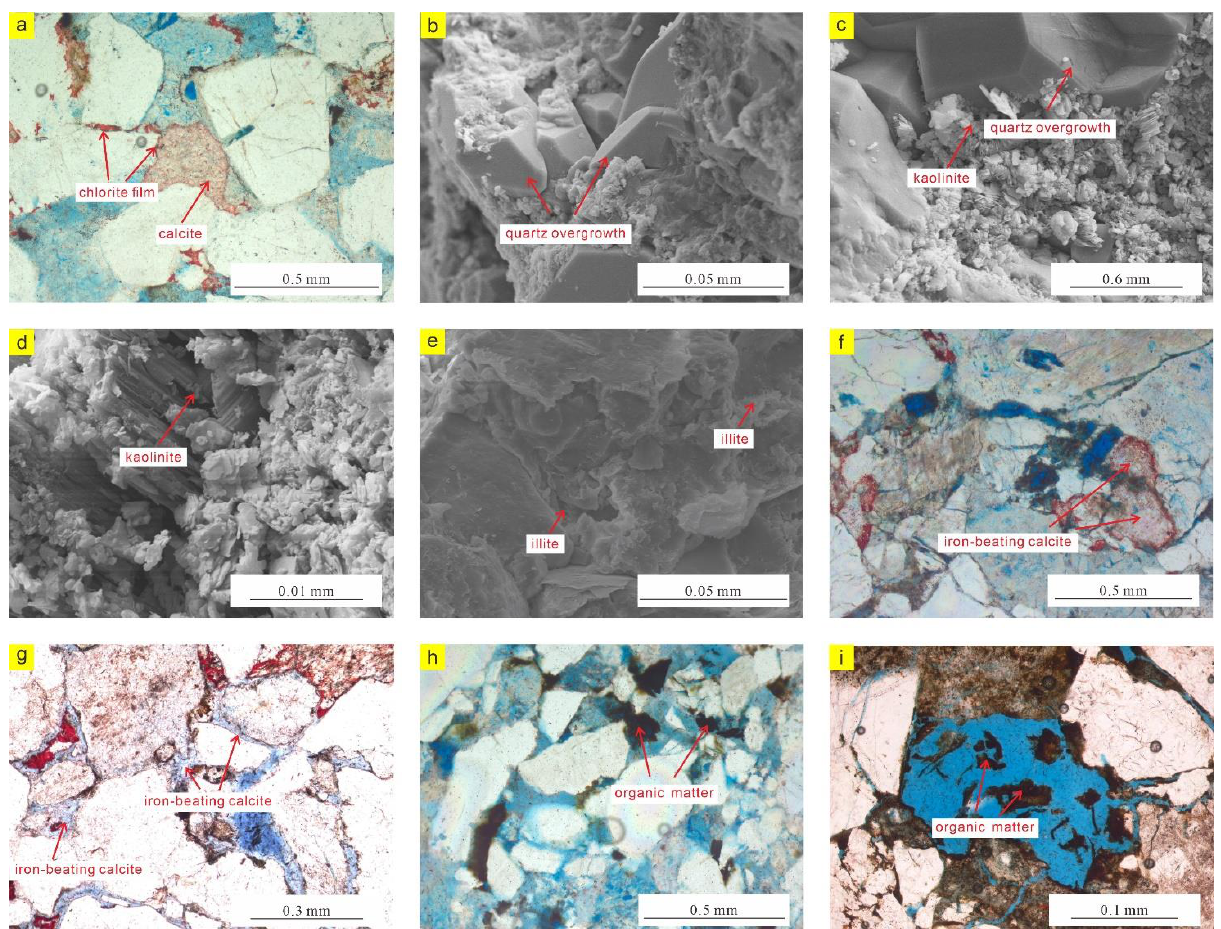
Figure 11. Characteristics of the paragenetic sequence of the Lower Jurassic reservoir in the Niudong area, northern margin of Qaidam Basin: ( a ) N1, 2227.9 m, chlorite film surrounded particles, calcite filled the intergranular pores; ( b ) N1, 2232.1 m, quartz overgrowth and authigenic quartz particles developed around quartz without chlorite film; ( c ) N1, 2231.7 m, quartz overgrowth and authigenic quartz particles developed around quartz without chlorite film, kaolinite adhered on the surface of the quartz overgrowth; ( d ) N102, 2115.8 m, kaolinite was visible in feldspar dissolution pores; ( e ) N102, 2038.6 m, illite were visible in feldspar dissolution pores; ( f ) N1, 2228.7 m, a small amount of iron-bearing calcite was visible in some feldspar dissolution pores and rock fragment dissolution pores; ( g ) EI2, 4050.5 m, iron-bearing calcite was visible in some feldspar dissolution pores and rock fragment dissolution pores; ( h ) N1, 2231.6 m, organic matter can be seen in feldspar or rock fragment dissolution pores; ( i ) N102, 2125.7 m, organic matter can be seen in rock fragment dissolution pores.